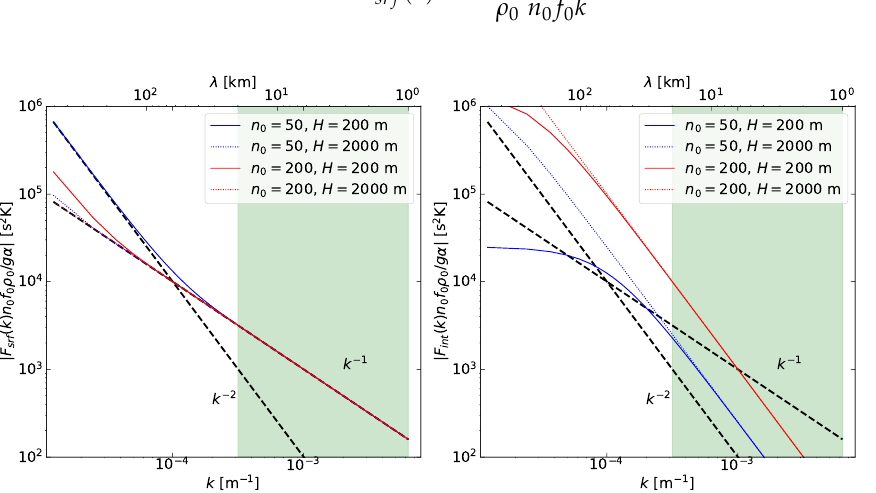
Figure 5. Surface transfer function F srf ( k ) ( left ) and interior transfer function F int ( k ) ( right ), both at the ocean surface. The dashed black line corresponds to k − 1 and k − 2 , and the green band the range of scales of interest, i.e., between 1 and 20